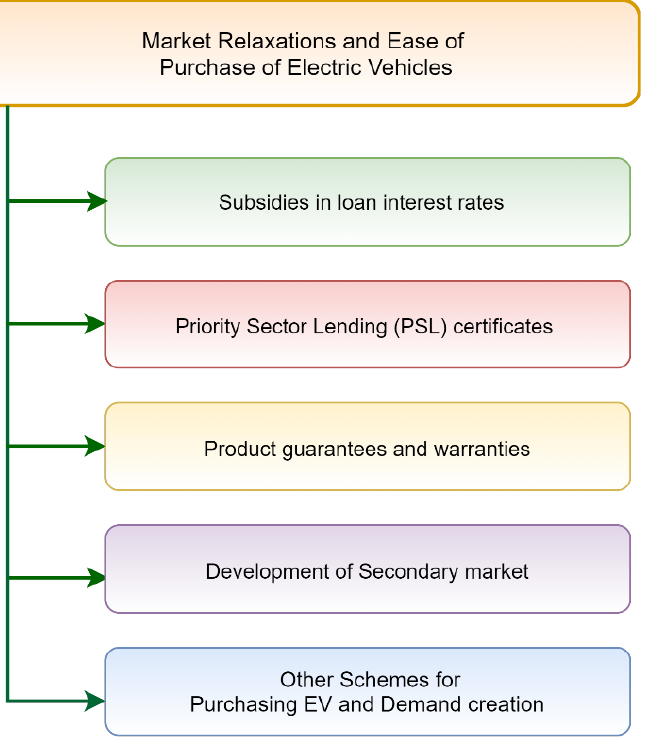
Figure 5. Represents the market relaxation offered by the government agencies for EV integration.